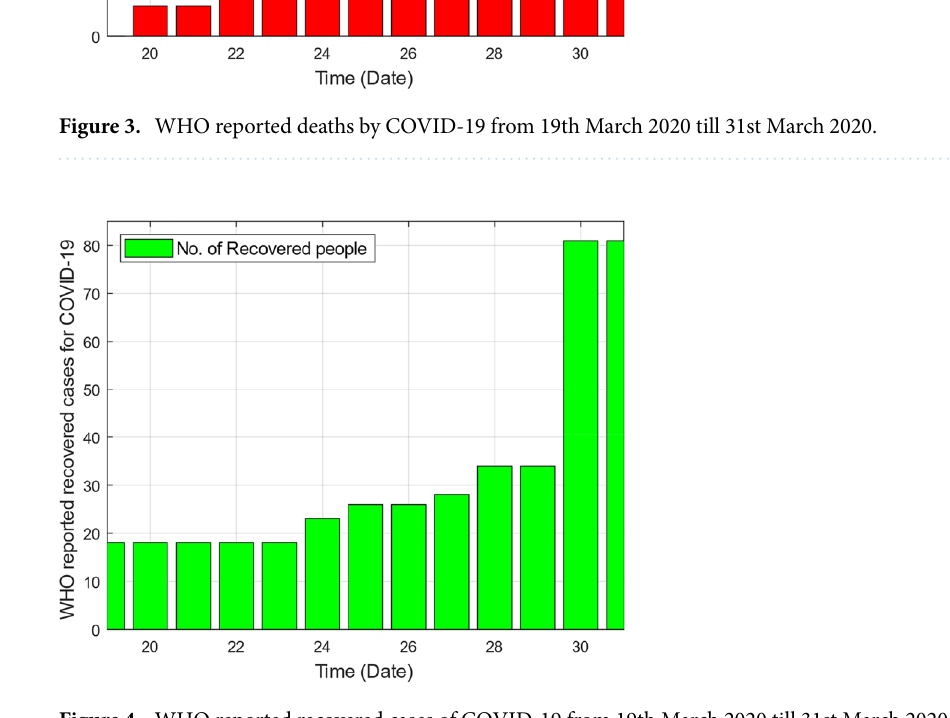
Figure 4. WHO reported recovered cases of COVID-19 from 19th March 2020 till 31st March